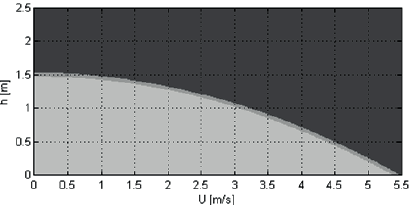
Fig. 1 Austrian hazard mapping criterion for torrential floods. Light grey: low hazard; grey: high hazard. Switzerland